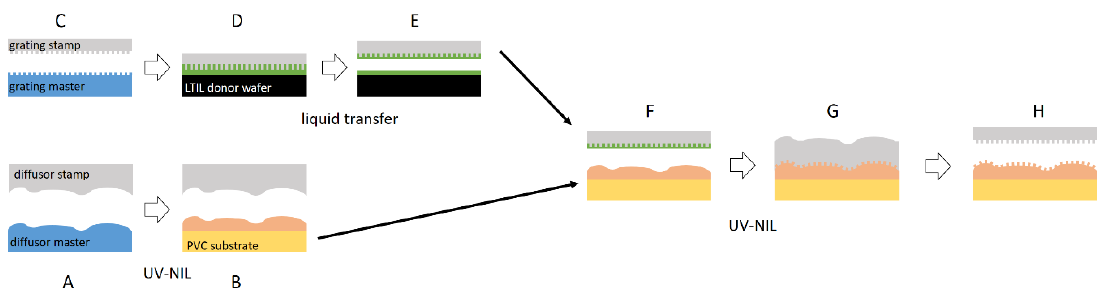
Figure 3. Process flow for master fabrication: First, a PDMS stamp from the diffusor master was fabricated ( A ), which is then used to imprint OrmoComp onto a PVC foil ( B ). Using a grating master, another PDMS stamp was made ( C ), which was used in an LTIL process ( D , E ) to print on the diffusor substrate ( F , G , H ). The flexible stamp conforms to the topography of the diffusor substrate as sketched in G. The results are the grating structures on top of the diffusor structures ( H ).